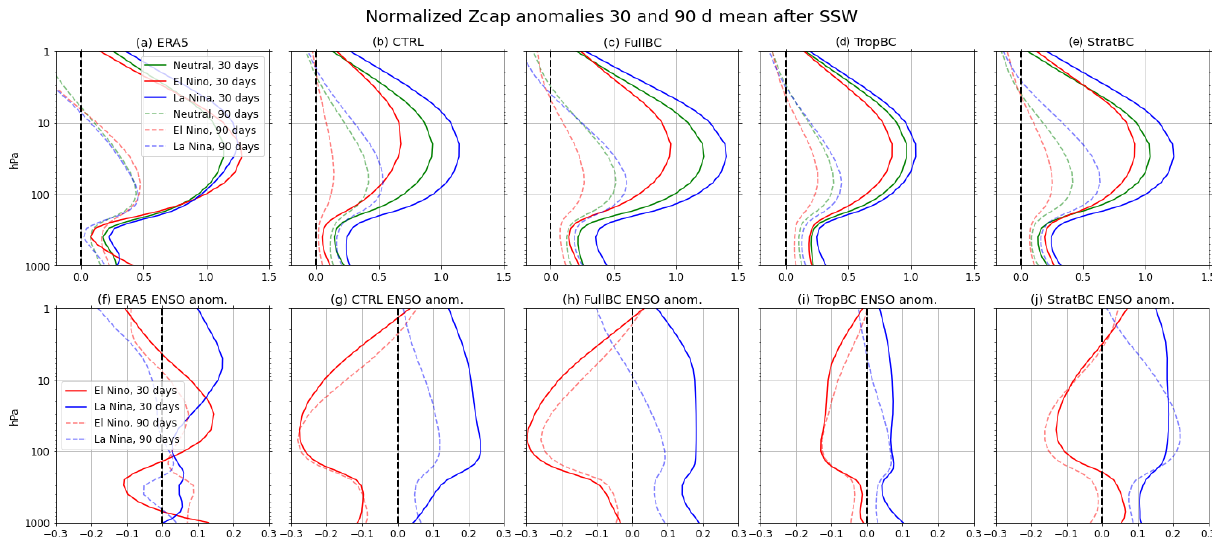
Figure 7. The top row shows normalized polar cap (60–90 ◦ N) geopotential height, composited around day zero of and time-averaged for 30 and 90d after SSWs, for neutral years (green), El Niño years (red), and La Niña years (blue). The bottom row shows the change in the mean Z cap SSW difference from neutral years due to El Niño (red) and La Niña